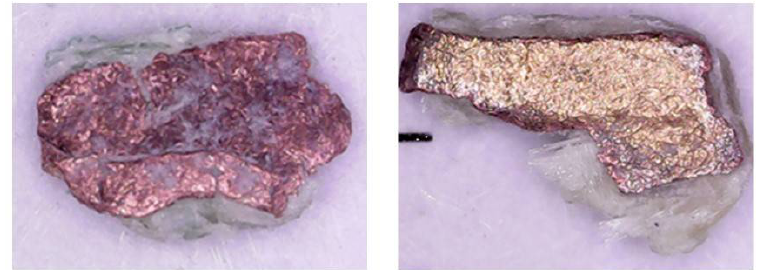
Figure 10. Photos of ground PCBs used in the leaching tests.